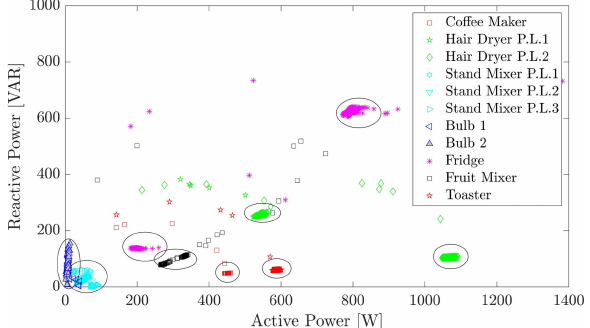
Figure 14. Appliances represented in the P-Q